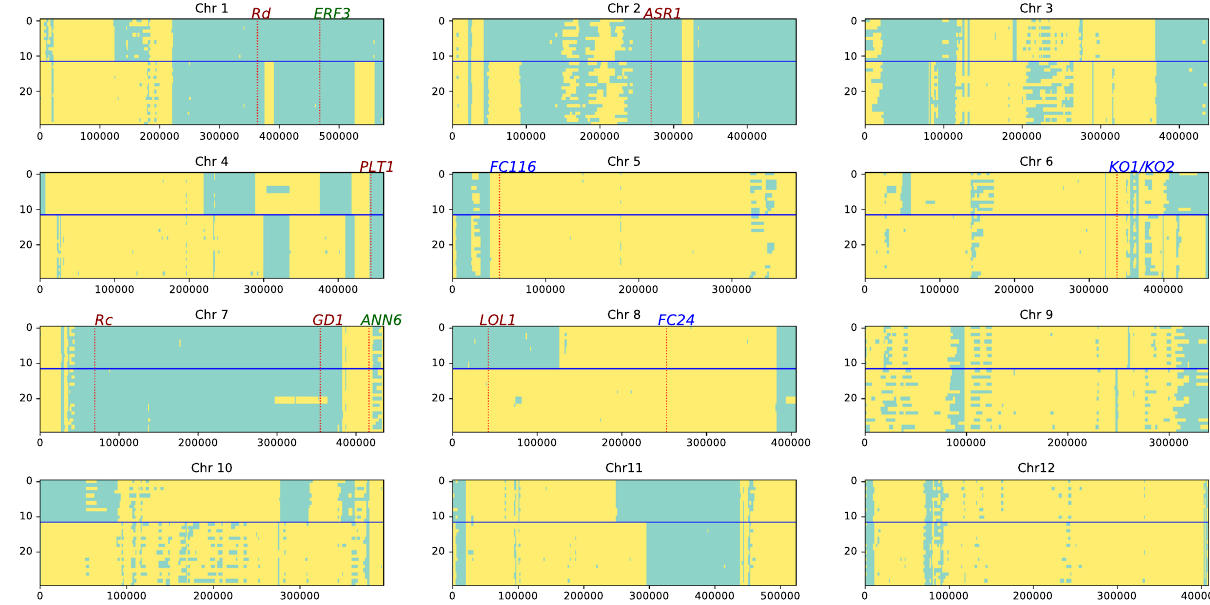
Fig. 5 Local ancestry inference for 15 SH_TEJ weedy rice individuals. Each panel corresponds to a single chromosome, with each individual represented by two rows. The top six individuals (12 rows) are SH1_TEJ individuals, and others are SH2_TEJ individuals. The x-axis indicates the number of SNP sites examined (not their physical location). The functionally known genes indicated in Fig. 3b and genes regulating plant height ( FC116 and FC24 ) are shown. Green-cyan: BH weedy rice ancestry, yellow: cultivated rice